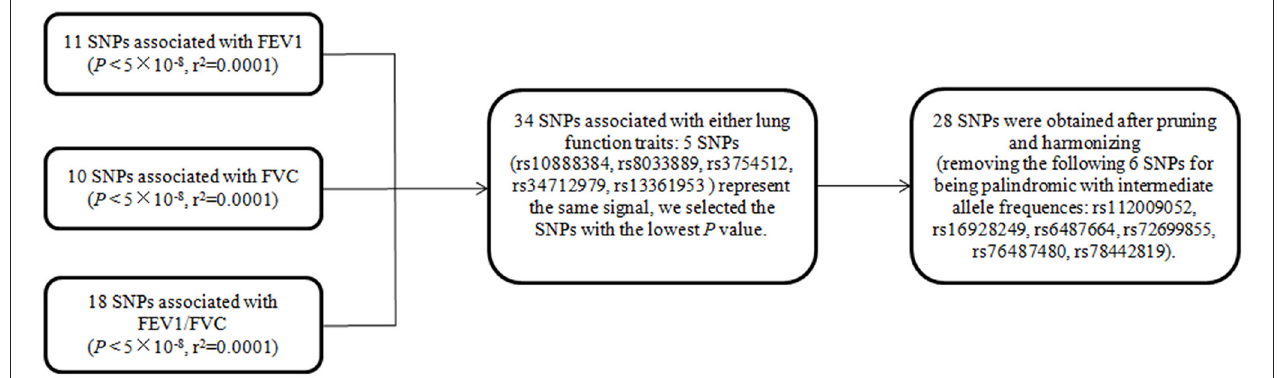
FIGURE 1 | The flow chart of SNP selection for multivariate MR. SNPs are a set of instrumental variable related to FEV1 and/or FVC and/or FEV1/FVC. FEV1, forced expiratory volume in one second; FVC, forced vital capacity; FEV1/FVC, the ratio of FEV1 over FVC; SNP, single nucleotide polymorphism.